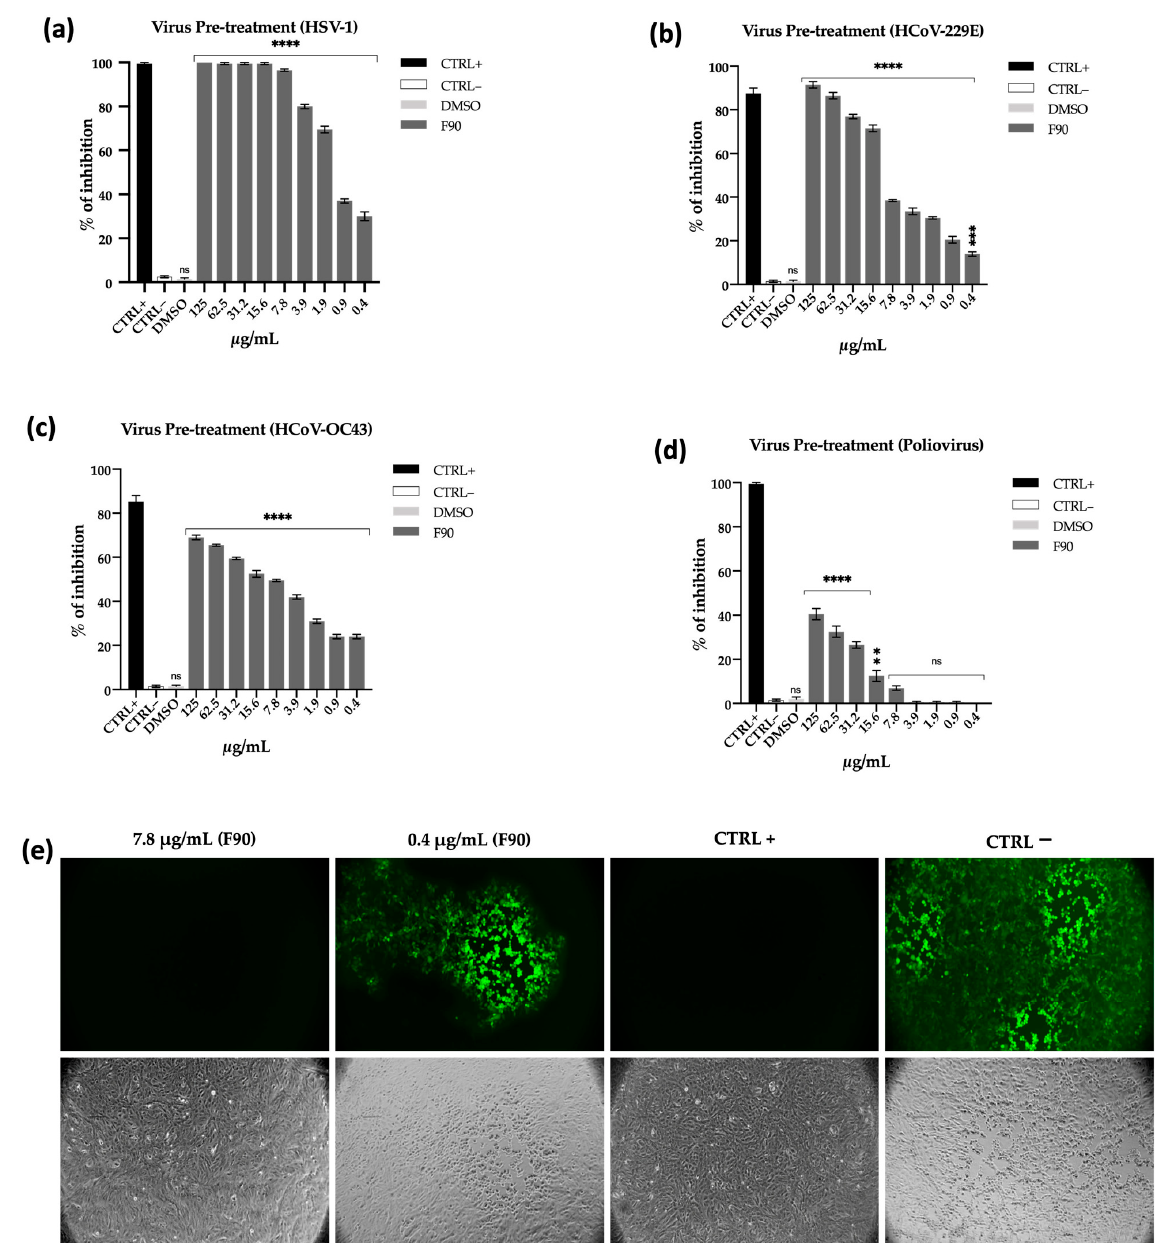
Figure 7. Antiviral activity of fraction 90% MeOH (F90). The antiviral activity of F90 was evaluated against three enveloped viruses: herpes simplex virus type 1 (HSV-1) ( a ), human coronavirus 229E (HCoV-229E) ( b ), human coronavirus OC43 (HCoV-OC43) ( c ), and the envelope-free Poliovirus PV-1 ( d ). F90 was tested, ranging from 125 to 0.4 µg/mL. ( e ) Green Fluorescent Protein herpes simplex virus type 1 (GFP HSV-1) was used to confirm the antiviral activity of F90 at 7.8 µg/mL (absence of fluorescence as CTRL+), while around 30% of inhibition is displayed at 0.4 µg/mL (presence of fluorescence). Greco extract and Pleconaril were used as positive controls (CTRL+). Untreated cells were used as negative control (CTRL–). DMSO was used as an internal negative control. Data are means of three independent experiments. Statistical significances are referred to the negative control. Differences between groups were determined by analysis of variance (ANOVA) and Dunnett’s test was used for multiple comparisons with the control. * p < 0.0332; ** p < 0.0021; *** p < 0.0002, **** p < 0.0001, ns (not significant).